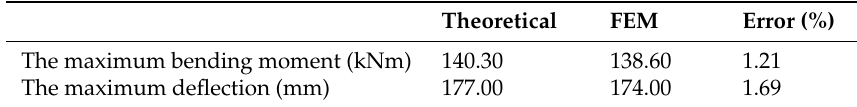
Table 2. Comparison of the FEM and the analytical solutions of the FFU composite beam under bending